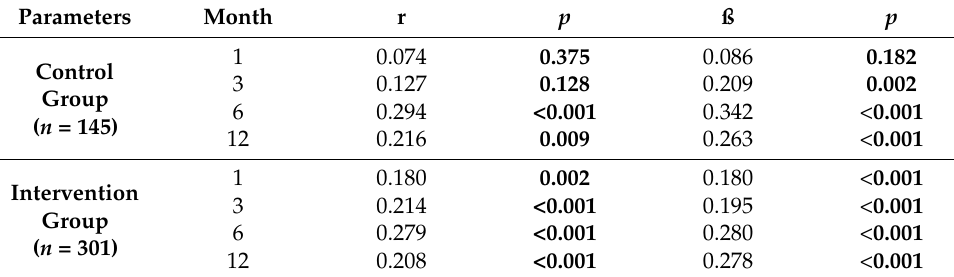
Table 2. Associations between ∆ fasting insulin and ∆ weight.